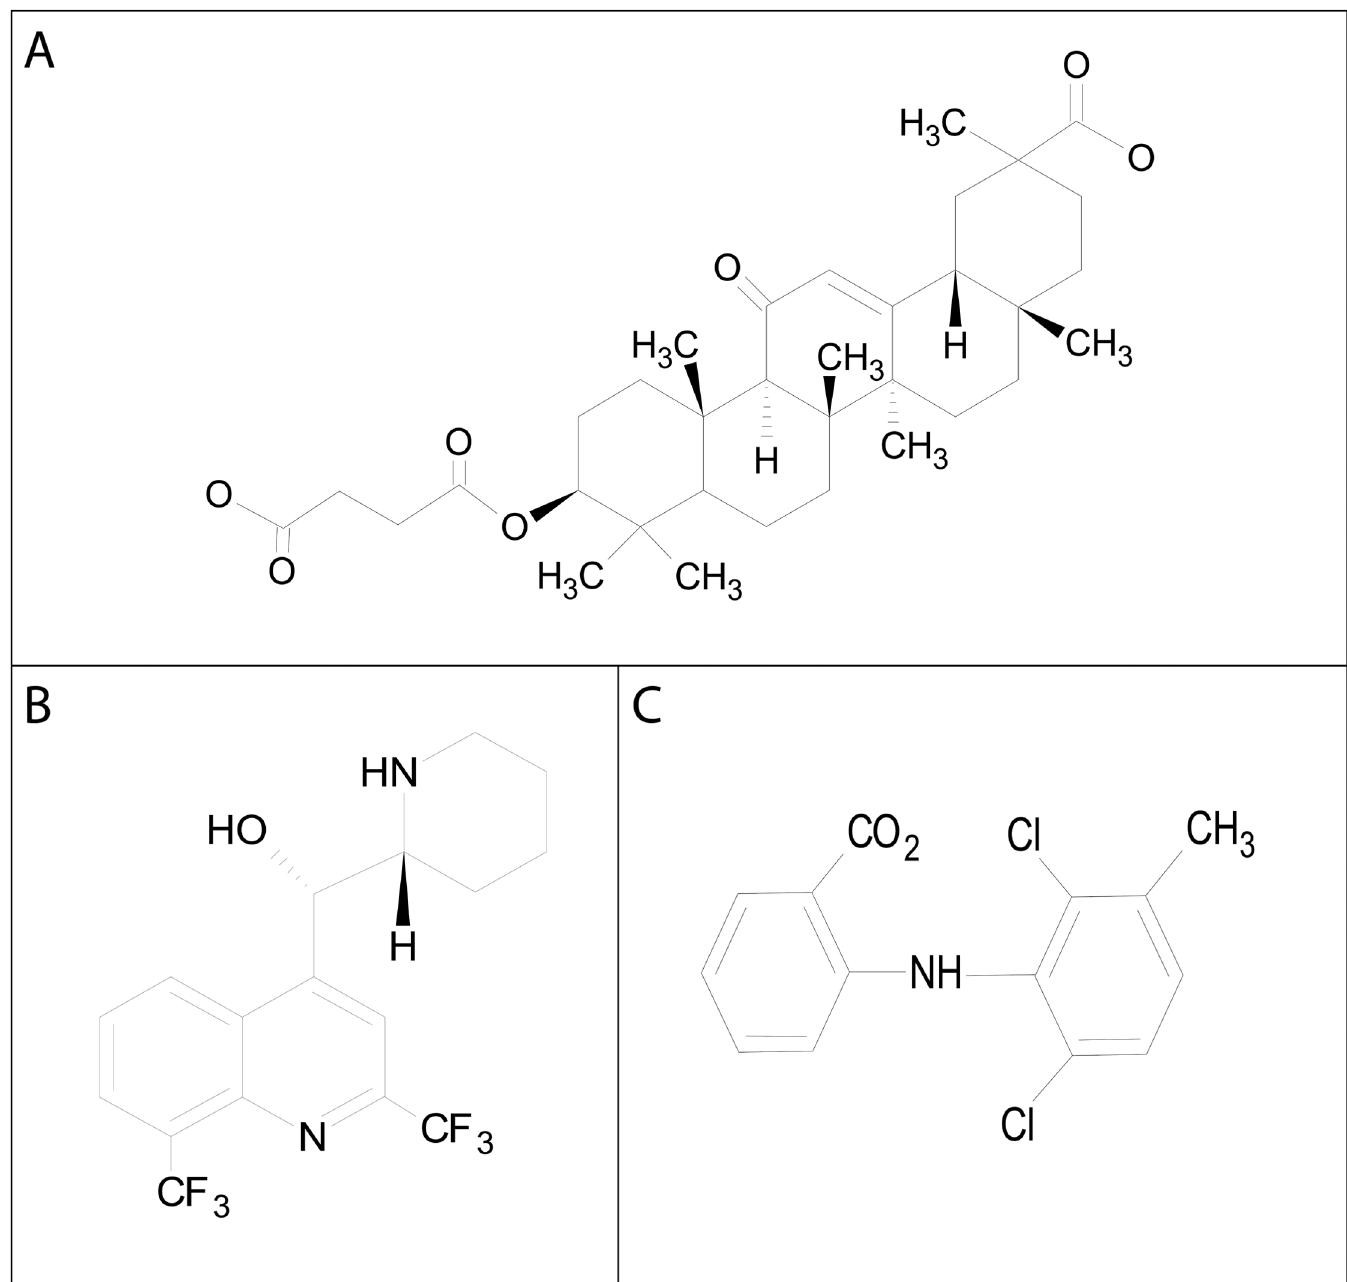
Fig 8. Molecular structures of the gap junction inhibitors: A) carbenoxolone, B) mefloquine, and C) meclofenamic acid. Structures as shown were modified from Sigma-Aldrich (www.sigma.com) and constructed in ChemSketch (ACD/Labs, Toronto, Ontario, Canada).